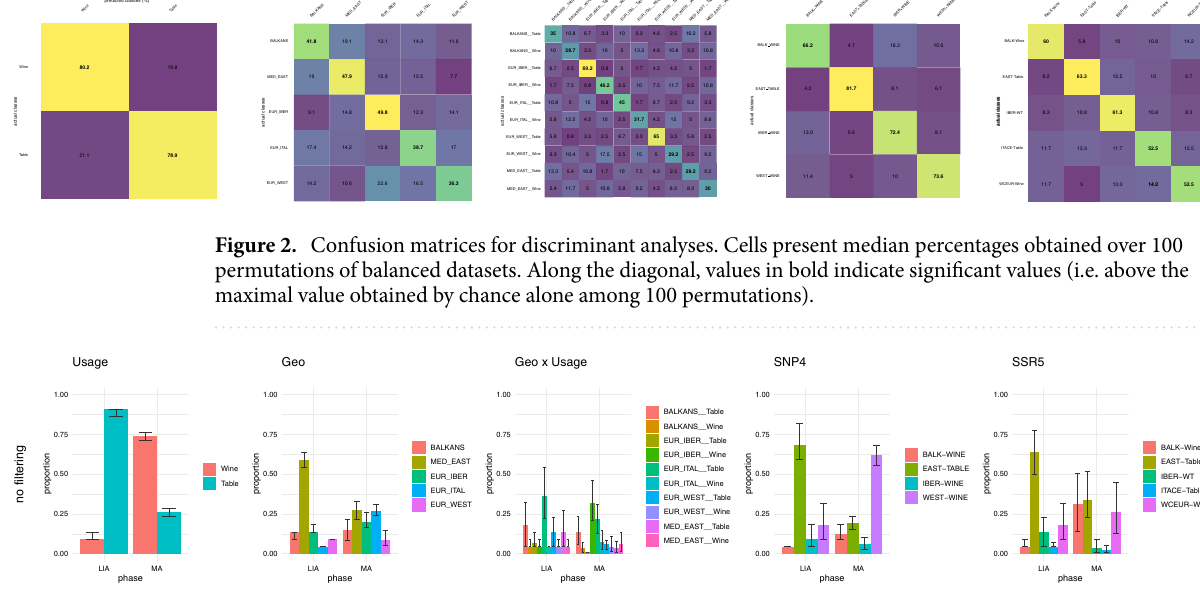
Figure 3. Inferences for archaeological pips of the domesticated type from the Mas de Vignoles XIV. The columns correspond to the different models presented after an inference on the wild/domesticated. The proportion are presented without filtering (see also Fig. F